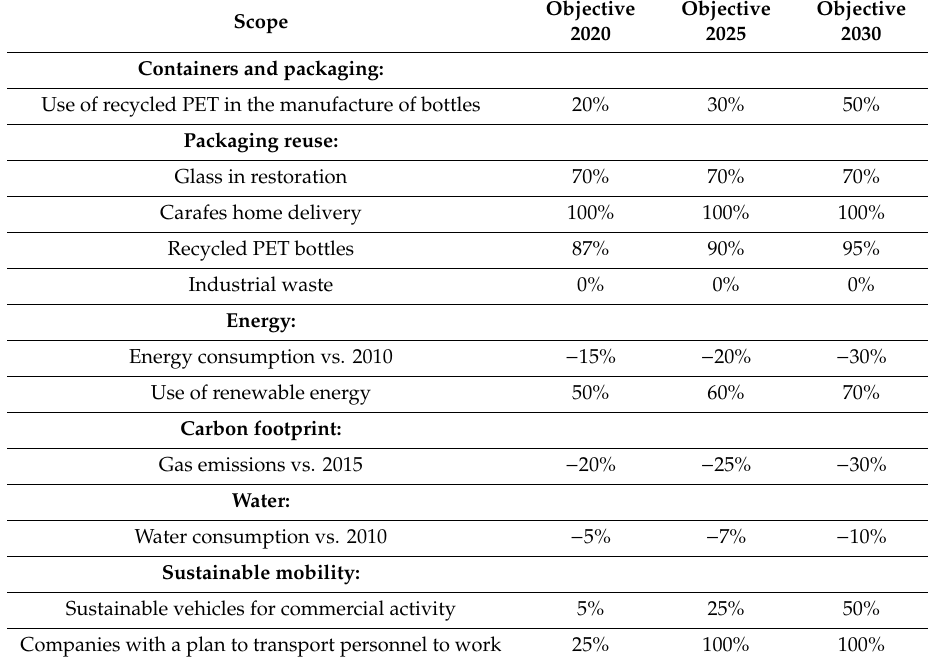
Table 1. Commitment to environmental sustainability and 2030 circularity in the mineral water sector. Source: ANEABE, 2018